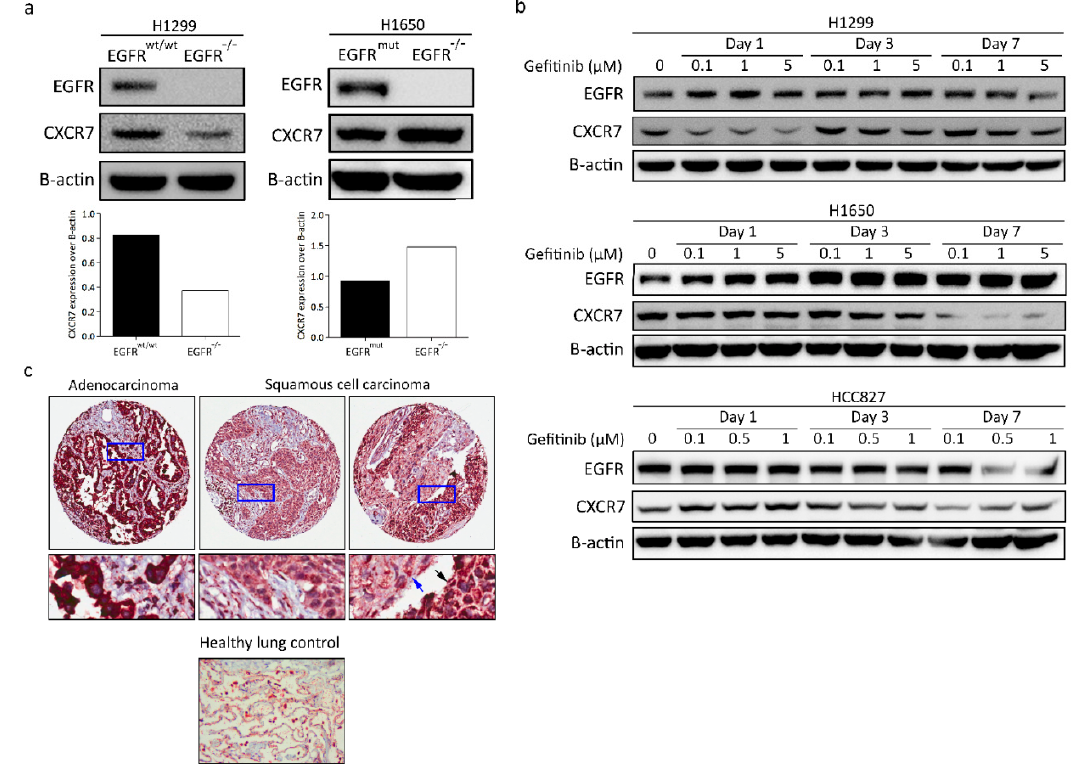
Figure 6. CXCR7 expression in different NSCLC cell lines with or without gefitinib treatment and CXCR7 expression in NSCLC patients. ( a ) Western blot analysis of H1299, H1650 EGFR wt/wt , and EGFR − / − cells. ( b ) Western blot analysis of H1299, H1650, and HCC827 cells treated with different doses of gefitinib over time. ( c ) Immunohistochemical staining of CXCR7 in NSCLC primary tumor samples ( n = 47). The blue and black arrows show the expression of CXCR7 in mature and less differentiated squamous cell lung carcinoma (SQCC), respectively.